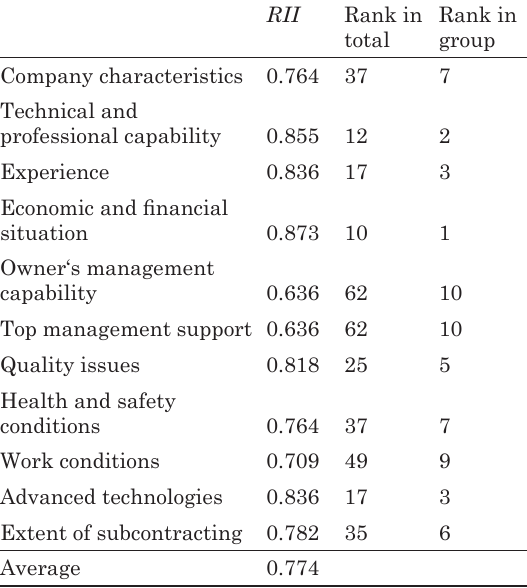
table 7. Summary of survey results on